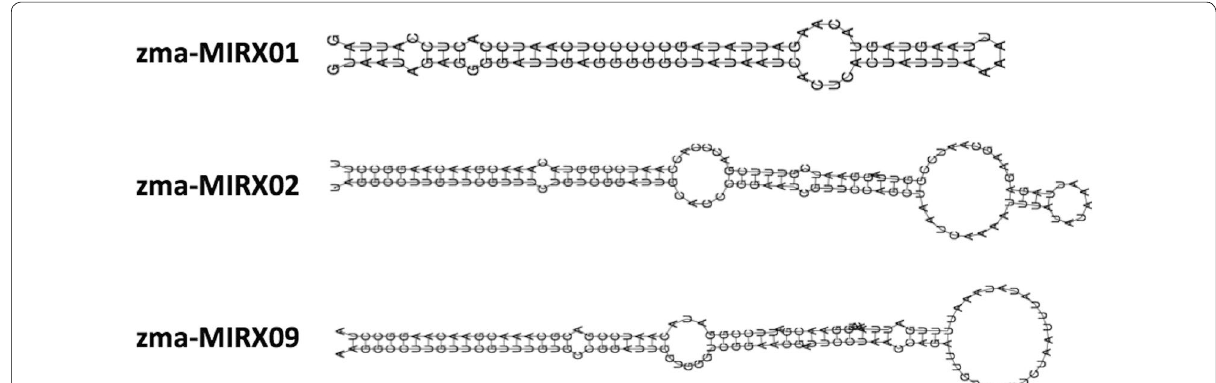
Fig. 5 Prediction of novel maize miRNAs. Examples of the structures of three predicted novel maize miRNAs. The prediction was performed using the PREFeR pipeline, which uses RNAfold (from the ViennaRNA package) algorithm to calculate and draw the pre‑miRNA hairpin structures